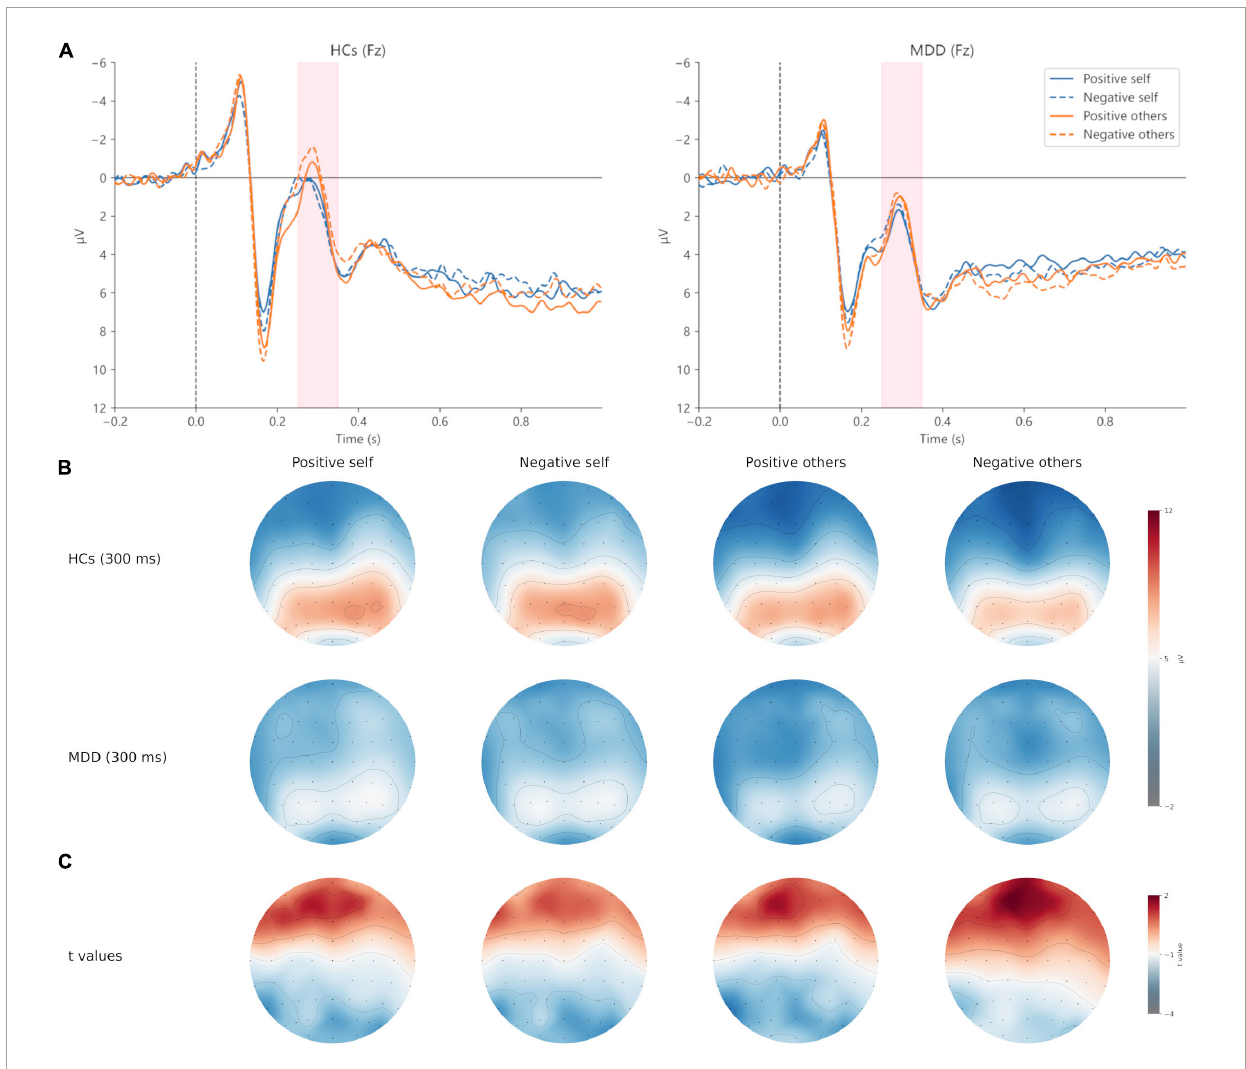
FIGURE3 Grand averages (A) of N200 (250–350 ms) at Fz electrodes under positive self (blue solid lines), negative self (blue dashed lines), positive others (orange solid lines), and negative others (orange dashed lines) condition. Topographic maps of N200 at 300 ms (B) under four conditions. Topographic distribution of t values for N200 between MDD and HCs (C) under four conditions. MDD, major depressive disorder; HCs, healthy